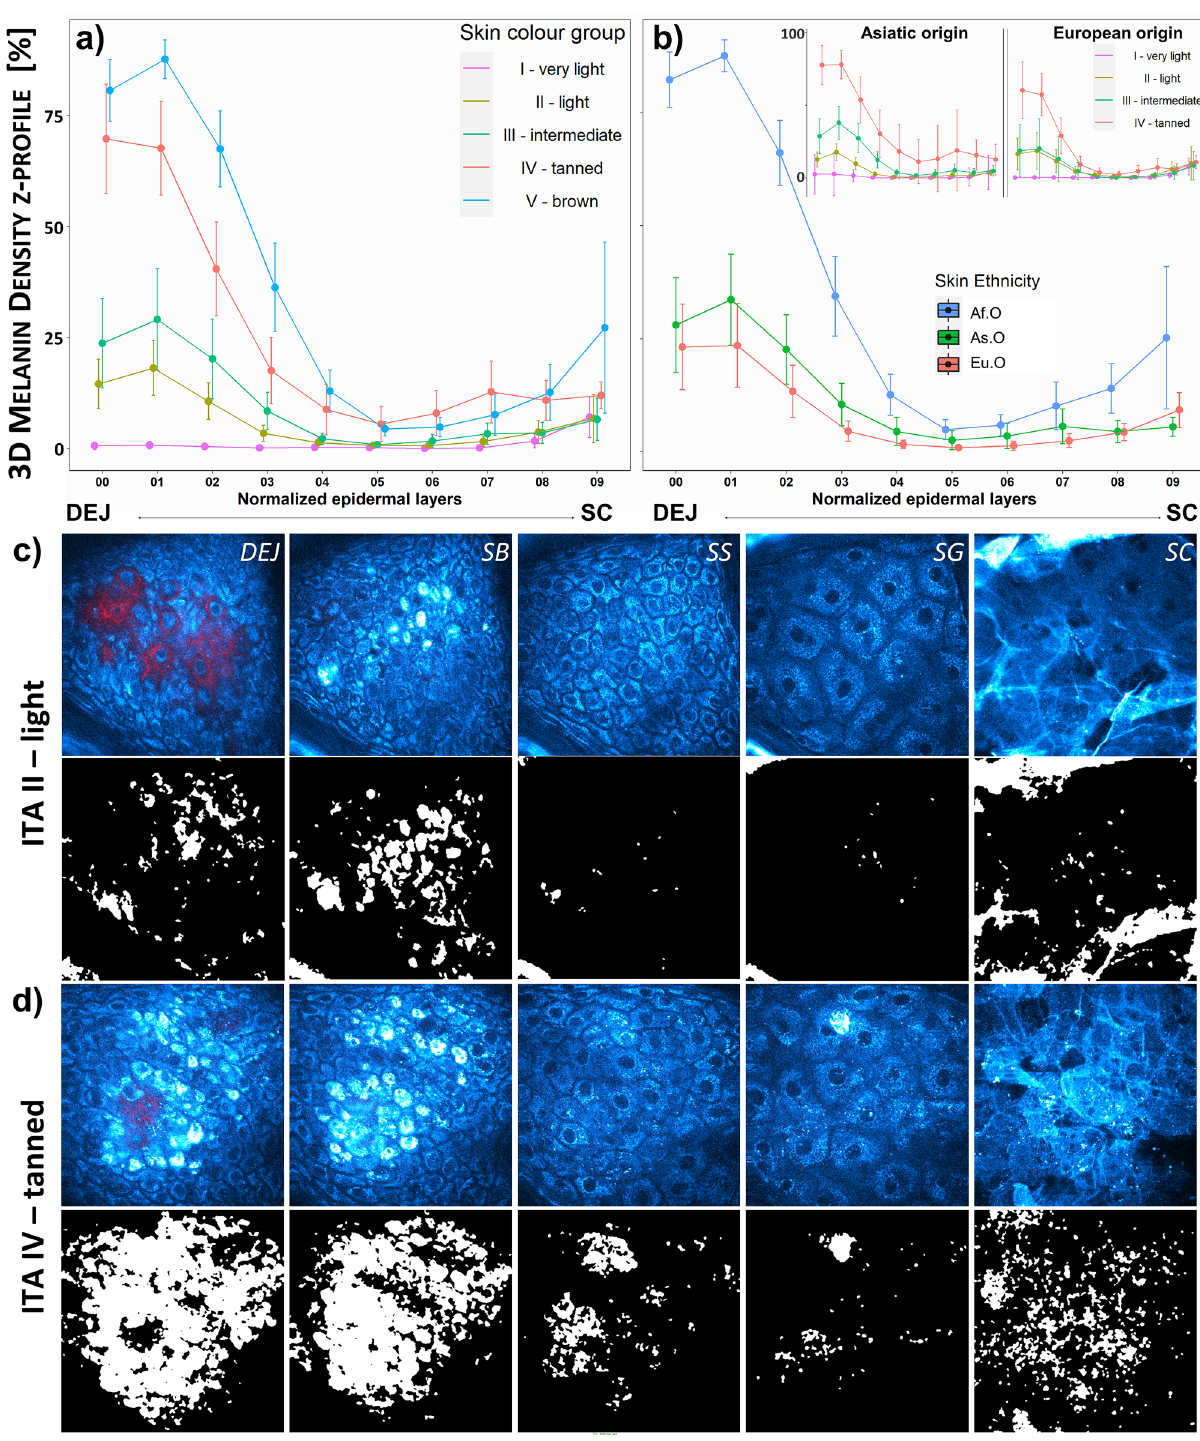
Figure 8. Modulation of z-epidermal distribution with skin color ITA grade and skin ethnicity in constitutive pigmentation study. Melanin density z-epidermal distribution profiles (mean 3D melanin density estimated in 12 thickness-normalized epidermal layers from 1—DEJ level to 12—SC level) of ( a ) different skin color ITA groups and b) different skin ethnicity. The insert in ( b ) is showing the z-profiles of different skin color ITA groups for Asiatic and European origins. The z-profiles data are expressed as mean ± confidence intervals of the mean. Raw 2PEF intensity images (cyan hot) and Pseudo-FLIM melanin masks (white) extracted from multiphoton z-stacks acquired on ventral forearms of volunteers with ( c ) light and ( d ) tanned skin color ITA groups. DEJ – dermal–epidermal junction level, SB - stratum basale , SS – stratum spinosum , SG - stratum granulosum and SC - stratum corneum